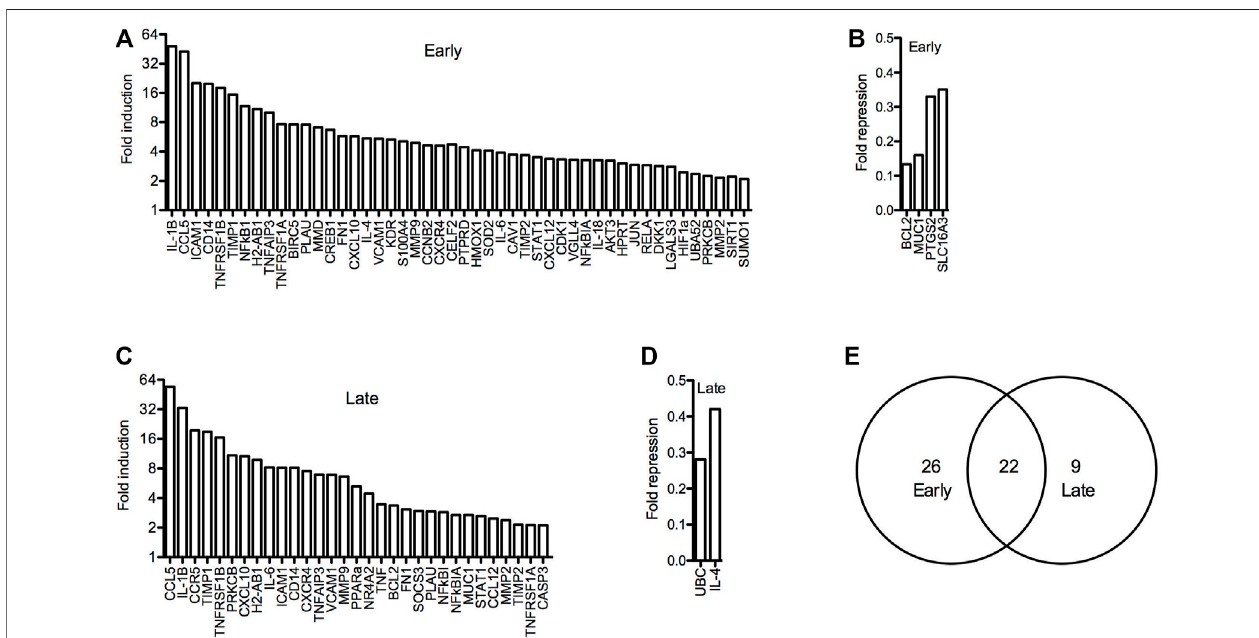
FIGURE 5 | Global gene expression pro fi les in hTNF- α joints. RT-qPCR panels were used to measure the expression of 88 genes associated with RA in wild-type andhTNF- α pawsatearlyandlatestagesofdisease. (A) Genesinducedbygreaterthan2-foldatearlystage. (B) Genesrepressedbygreaterthan0.5-foldatearlystage. (C) Genes induced by greater than 2-fold at late stage. (D) Genes repressed by greater than 0.5-fold at late stage. (E) Comparison of induced genes at early and late stages.